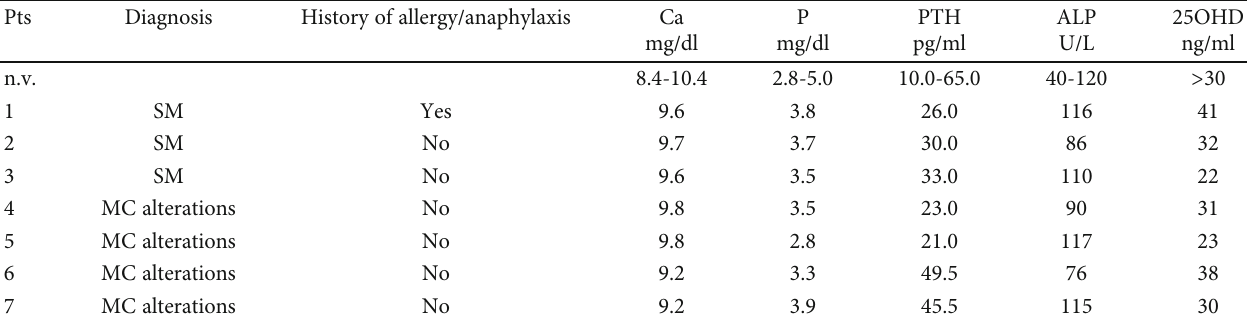
Table 2: Mineral metabolic features in patients with SM and MC alterations.